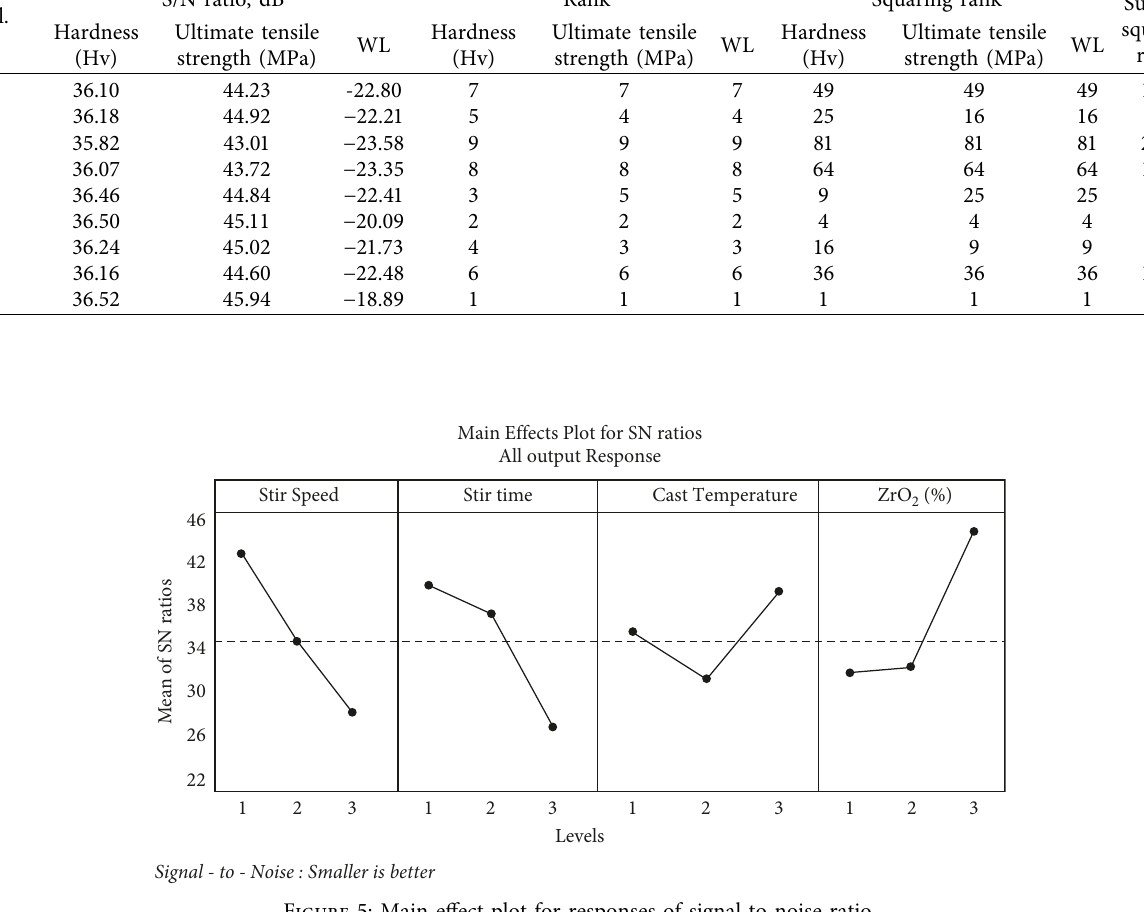
Figure 5: Main effect plot for responses of signal to noise